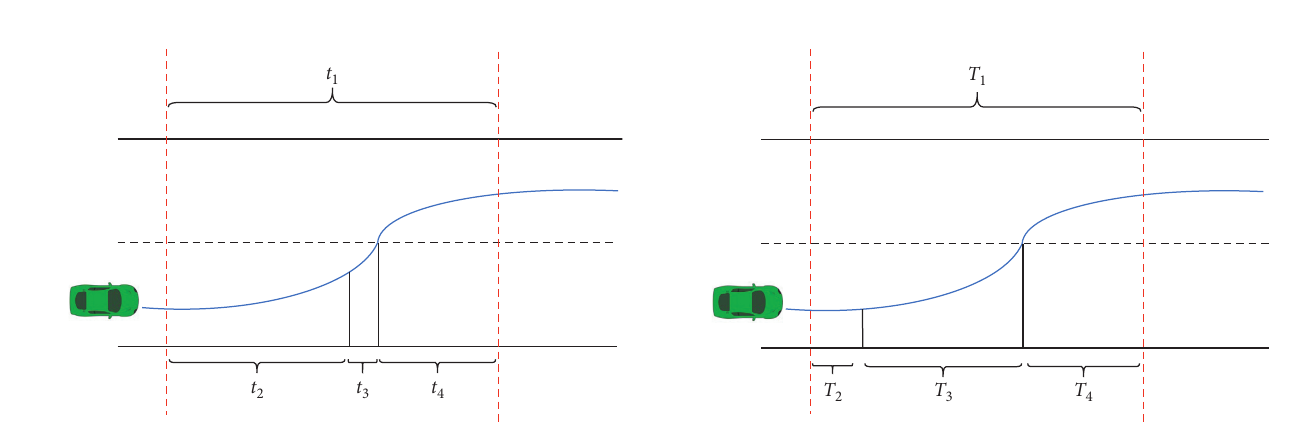
Figure 15: Prospective time for once shrunk time window. Figure 16: Prospective time for twice shrunk time